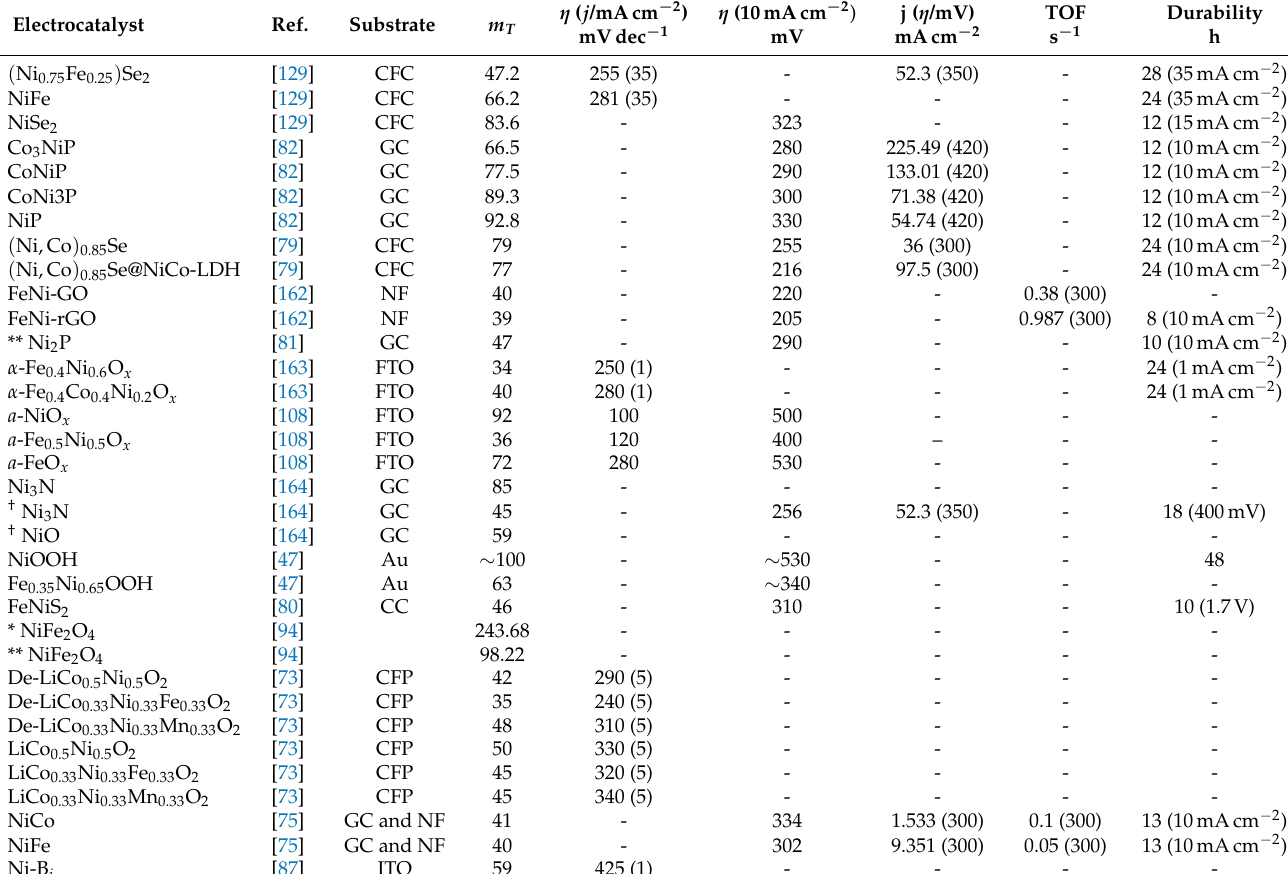
Table 3. Performance parameters of nickel-based electrocatalysts for OER in alkaline media. Electrocatalyst